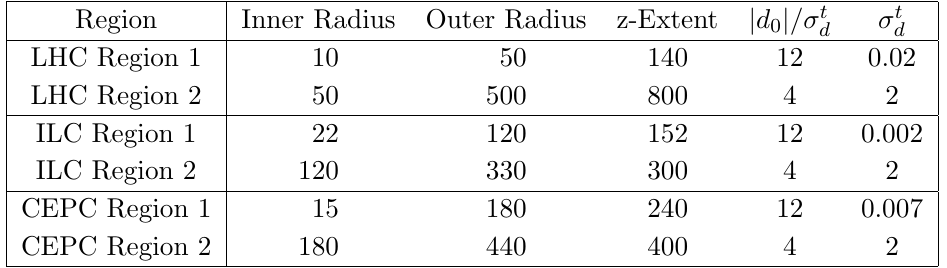
Table 1 . Parameters of simpli(cid:12)ed detector geometries representing current and future detectors, namely LHC [55], ILC [46, 47], CEPC [48]. All length units are in cm. Circular Electron Positron Collider (CEPC). We consider a center-of-mass energy of p s = 250 GeV and a luminosity of 5000 fb (cid:0) 1 . The dominant Higgs production process at an electron-positron collider is Higgs-Strahlung, e + e (cid:0) Z (cid:3) Zh 1 . In the SM, the cross ! ! section is (cid:27) 240 fb for p s = 250 GeV. Further suppression of the cross-section occurs in (cid:24) our case, due to the Higgs mixing angle (see (cid:12)gure